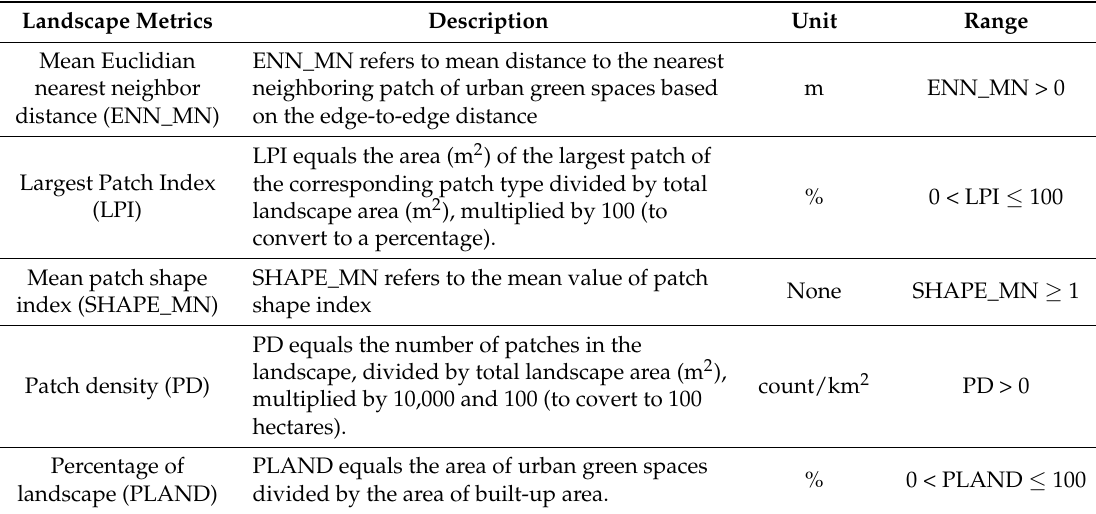
Table 1. Descriptions of the landscape metrics